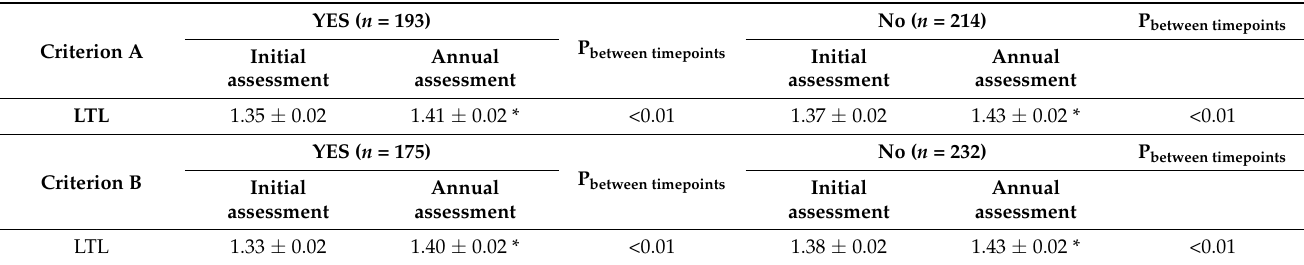
Table 3. LTL measurements and respective comparisons at baseline and at 12 months follow-up of participants with “good compliance” ( n = 407), according to criterion of success at weight loss. Subjects were considered successful at weight loss (“YES” group), either if respective BMI z-score decreased more than 0.6 at 12 months follow-up (Criterion A), or if respective IOTF category (normal weight, overweight and obese) improved by one or more categories (Criterion B). Unsuccessful participants (“NO” group) were participants not fulfilling the respective criteria.